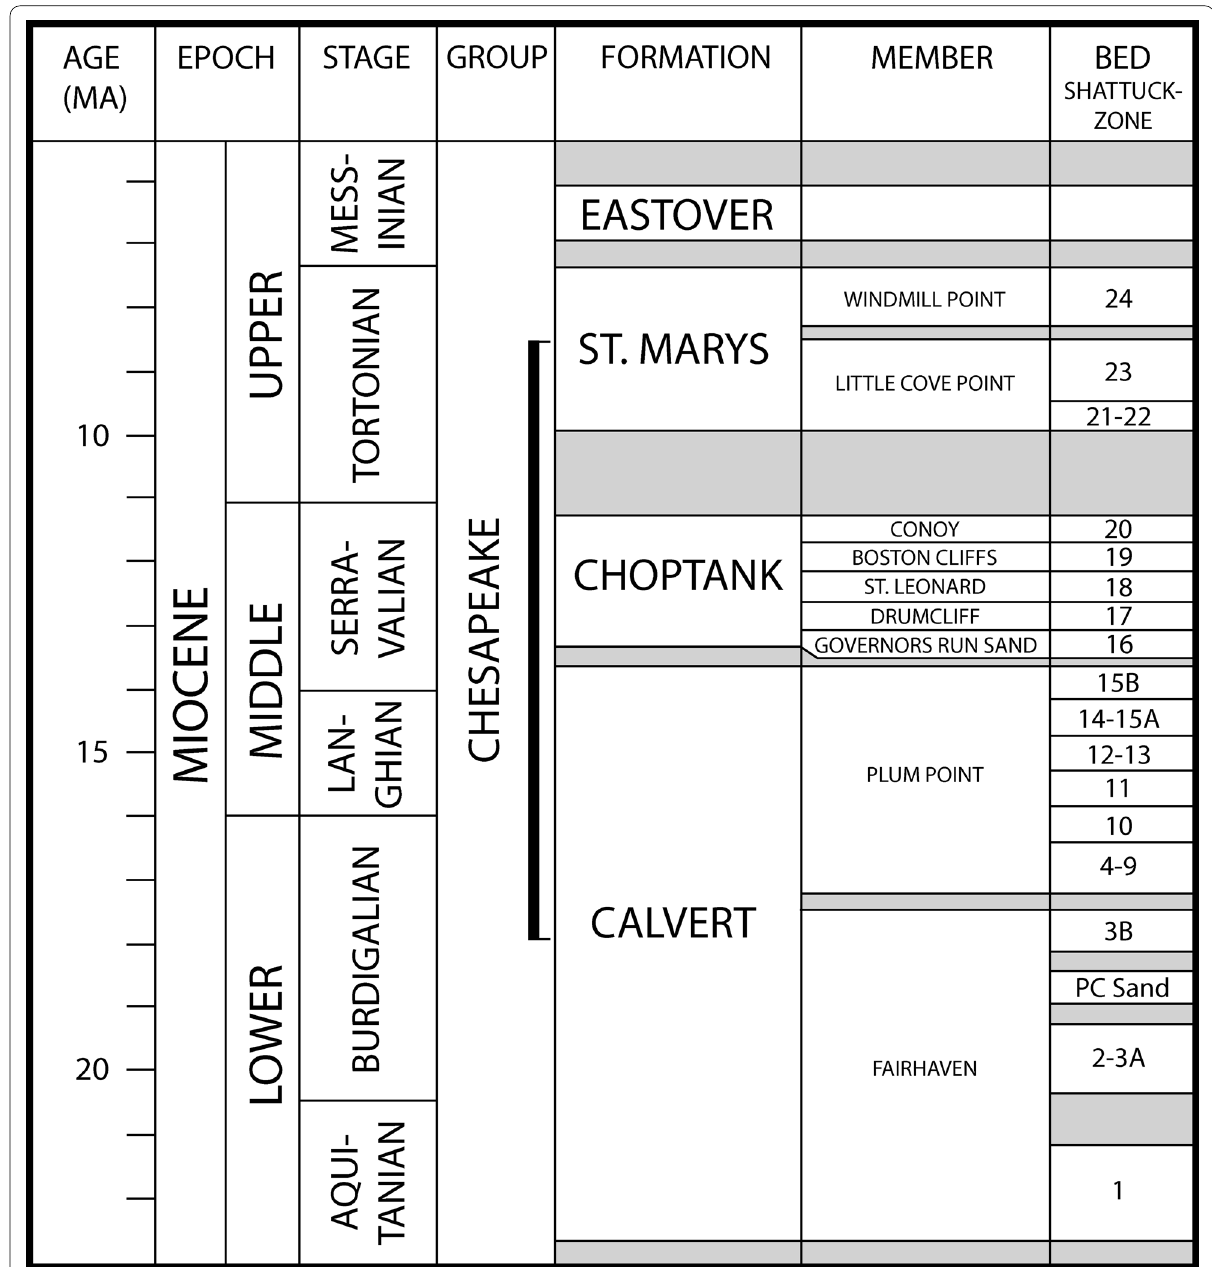
Fig. 2 Ages and stratigraphic correlation chart of the Miocene portion of the Chesapeake Group. The dark bracket within the Group column designates that part of the Chesapeake Group represented by the sediments along Calvert Cliffs. The Eastover Formation crops out in Virginia. PC Sand “Popes Creek Sand” and is not a Shattuck-Zone. From Weems (pers. comm.) and modified from Powars (2013) and Vogt et al. =